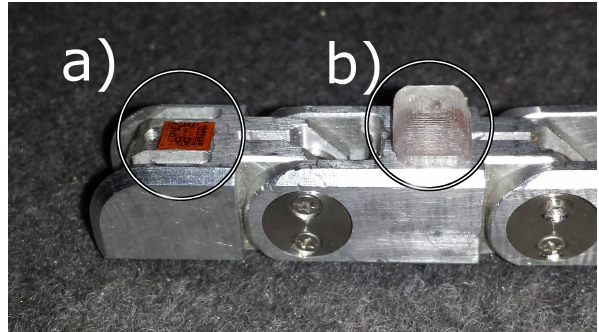
Figure 2: Tactile sensors mounted on the robot’s fingers. On the left (a): Hall effect sensor. On the right (b): Full tactile sensor with the soft elastometer body and